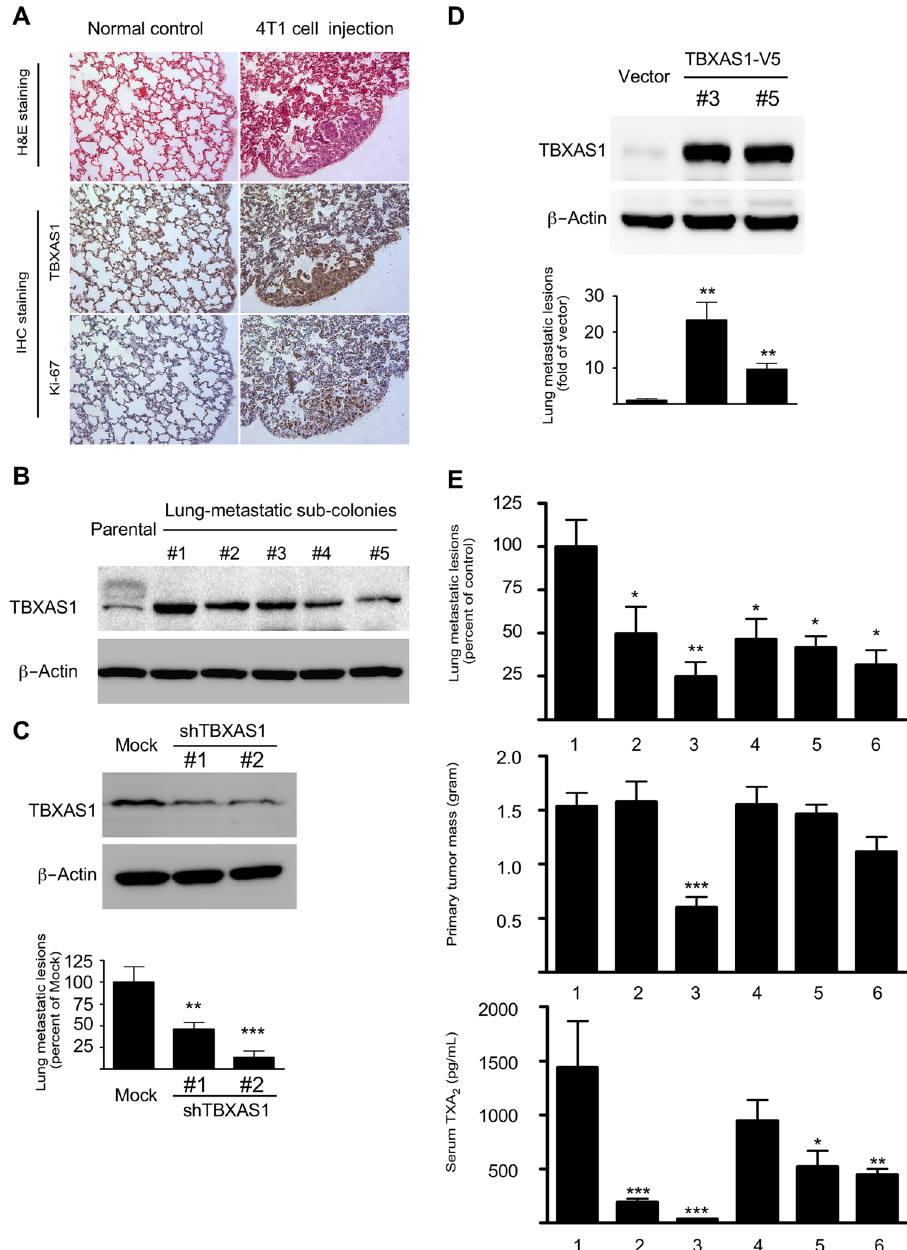
Fig. 4 Breast cancer metastasis is attenuated by targeting the TXA 2 pathway. a Murine 4T1 tumor cells spontaneously metastasize from the primary tumor (mammary gland) to the lung. Immunohistochemical staining showed that metastatic foci in lung strongly express TBXAS1. b Compared with parental cells, 4T1sub-line cells isolated from lung metastatic foci generally express much higher levels of TBXAS1. c Knockdown of TBXAS1 decreases the ability of 4T1 cells to metastasize to the lung. Data are presented as mean values ± S.E.M. ( n = 6). The asterisks indicate a signi fi cant difference compared with Mock control (** p < 0.01; *** p < 0.001). d Ectopic expression of TBXAS1 increases the ability of 4T1 cells to metastasize to the lung. Data are presented as mean values ± S.E.M. ( n = 6). The asterisks indicate a signi fi cant difference compared with vector control (** p < 0.01). e Pharmacological blockage of TXA 2 biosynthesis suppresses breast cancer metastasis to the lung. Drug treatment: 1, vehicle; 2, aspirin (100 mg/kg); 3, indomethacin (1 mg/kg); 4, celecoxib (10 mg/kg); 5, ozagrel sodium (100 mg/kg), 6, fi sh oil (500 mg/kg). Data are presented as mean values ± S.E.M. ( n = 10). The asterisks indicate a signi fi cant difference compared with vehicle control (* p < 0.05, ** p < 0.01, *** p <